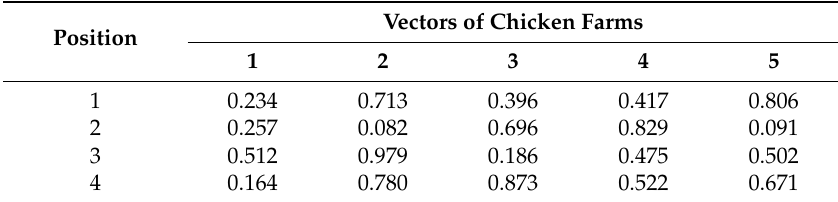
Table 2. Initial target vectors of chicken farms.